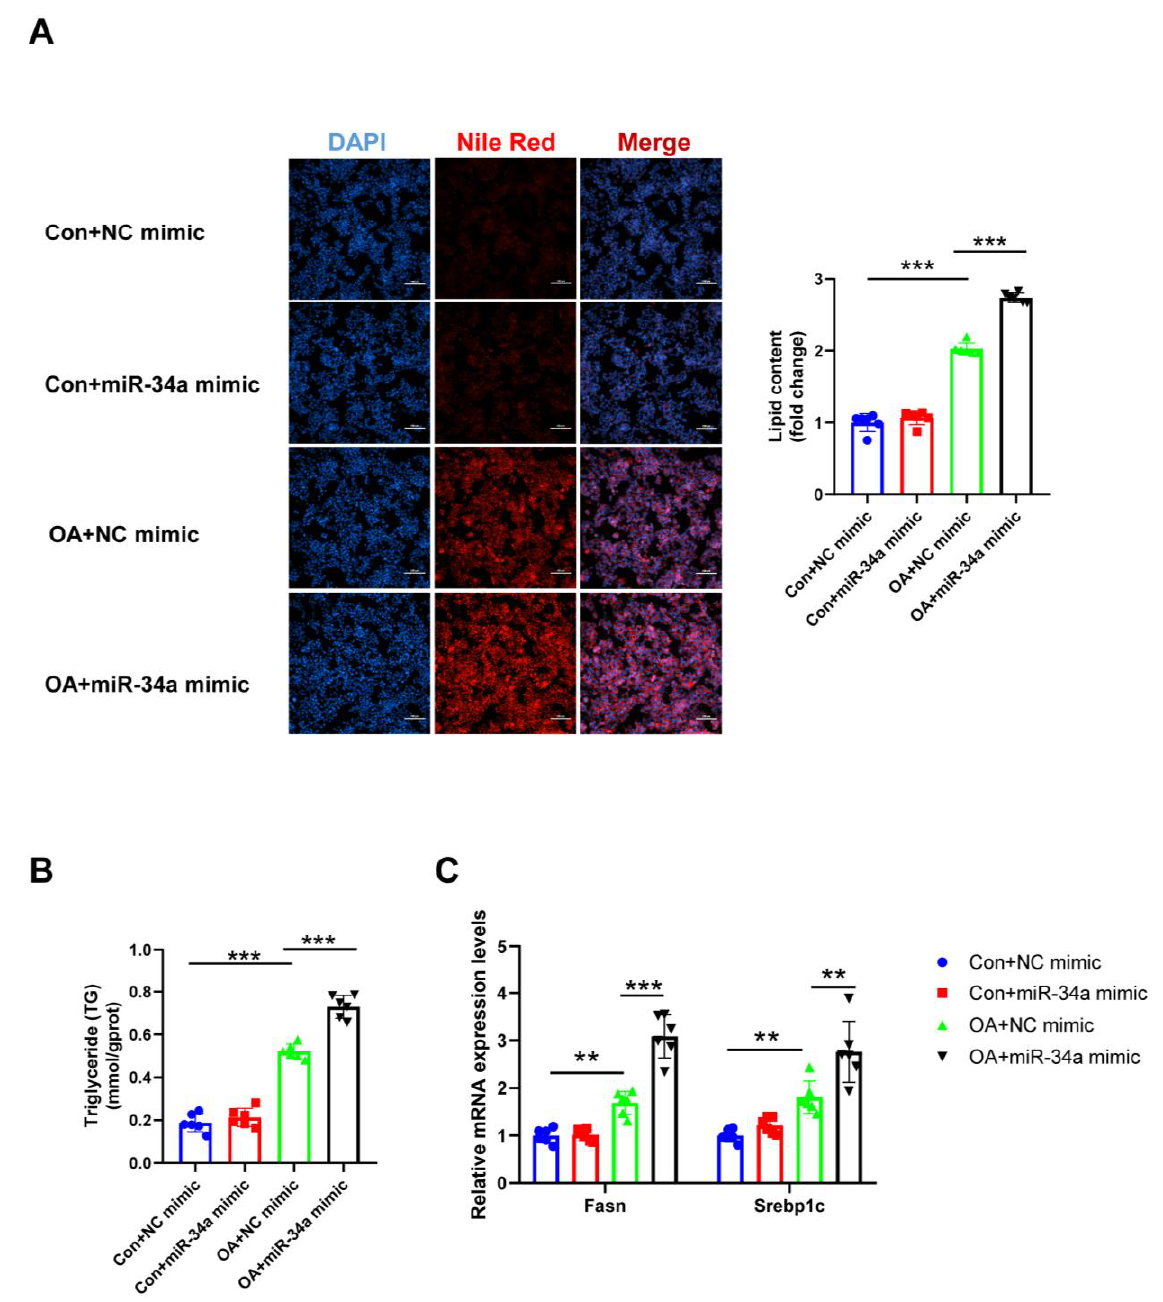
Figure 8. Effects of miR-34a mimicking on lipogenesis in hepatocytes. ( A ) The lipid content of HepG2 cells was determined by Nile Red staining. ( B ) The TG levels of HepG2 cells. ( C ) The mRNA levels of lipogenesis-related genes (Fasn and Srebp1c) relative to GAPDH were analyzed by qRT-PCR. ** p < 0.01, *** p < 0.001; n = 6. OA, oleic acid; TG, triglyceride; Fasn, fatty acid synthase; Srebp1c, sterol regulatory element binding protein-1c. Scale bar = 100 μ m.